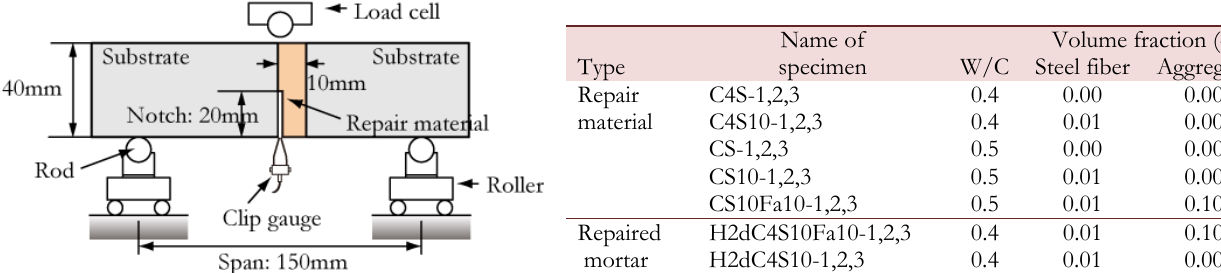
Figure 1: Specimen and test setup. Table 1: Attributes of repairs used for specimens.